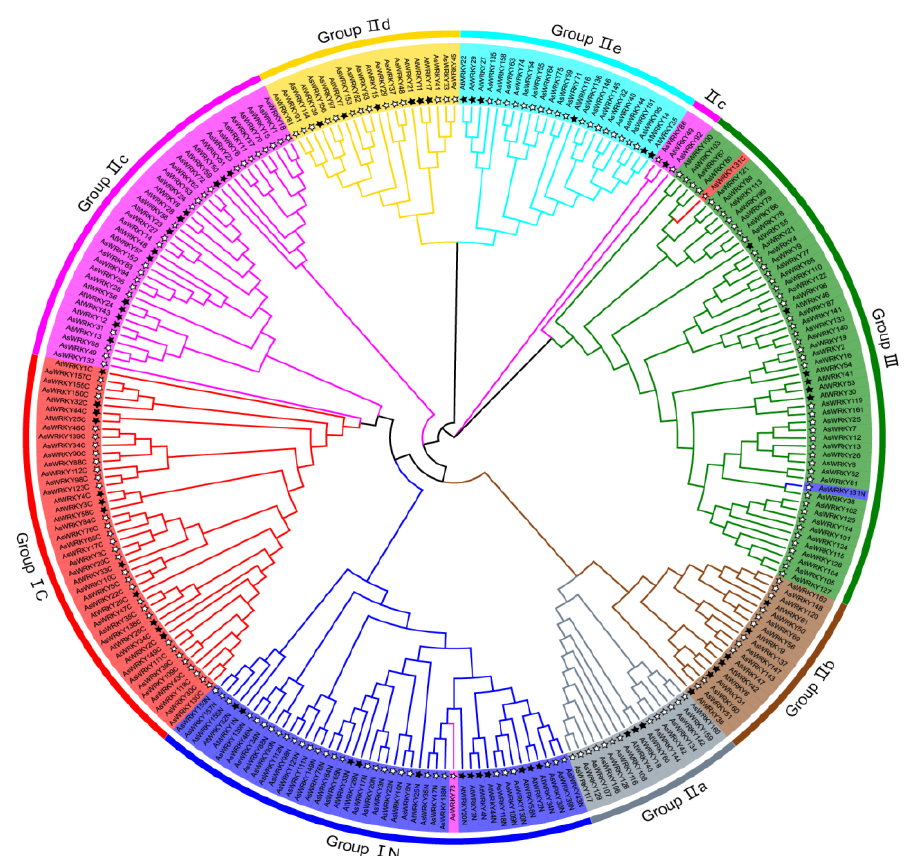
Figure 2. Phylogenetic relationship of AsWRKY domains among the Arabidopsis and oat. Different colored arcs are used to distinguish different groups or subgroups. The black solid star and hollow star represent Arabidopsis and oat, respectively.